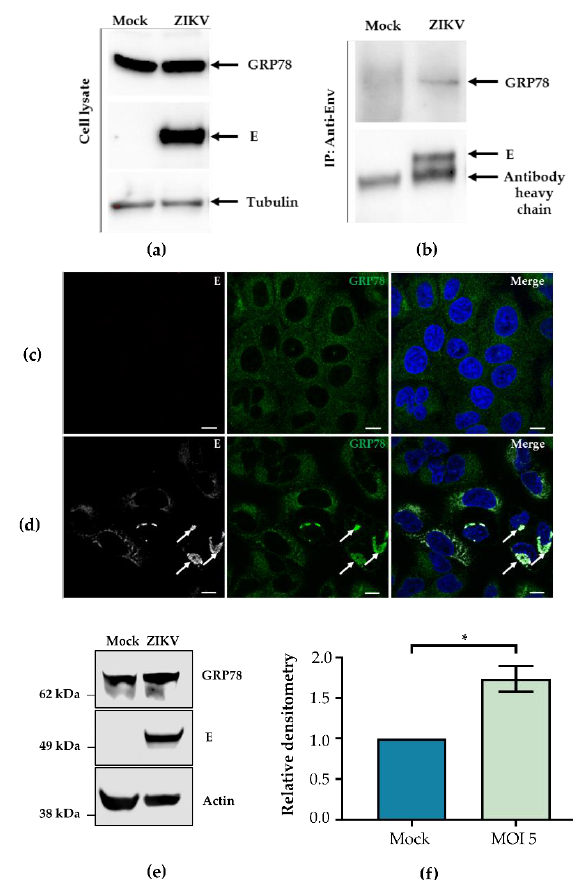
Figure 1. ZIKV infection modulates GRP78 localisation and expression in A549 cells. A549 cells were infected with ZIKV PE243 at multiplicity of infection (MOI) 1 for 24 h. ( a ) Cells lysates were probed for protein expression by Western blot analysis with antibodies against GRP78, ZIKV E, and a tubulin loading control; ( b ) these cell lysates were incubated with a ZIKV anti-E antibody prior to the addition of protein G magnetic beads to carry out immunoprecipitation (IP). This was followed by Western blot analysis. A549 cells seeded onto coverslips were ( c ) mock treated or ( d ) infected with ZIKV PE243 at MOI 0.1 for 24 h. ZIKV E is shown in white, GRP78 in green, and nuclei were stained with DAPI shown in blue. Scale bars represent 10 µm. Images were taken on an LSM 710 confocal microscope. ( e ) A549 cells were infected with ZIKV PE243 at MOI 5 for 24 h. Western blots for GRP78, E, and actin expression were performed on cell lysates. A representative image is shown. ( f ) Densitometry of GRP78 expression from triplicate Western blots shown relative to an actin loading control. Error bars represent standard error of the mean of triplicate repeats. An unpaired Student’s t - test with Welch’s correction was used to determine statistical significance where * p -value < 0.05. ( a – e ) Shown are representative images from triplicate experiments.